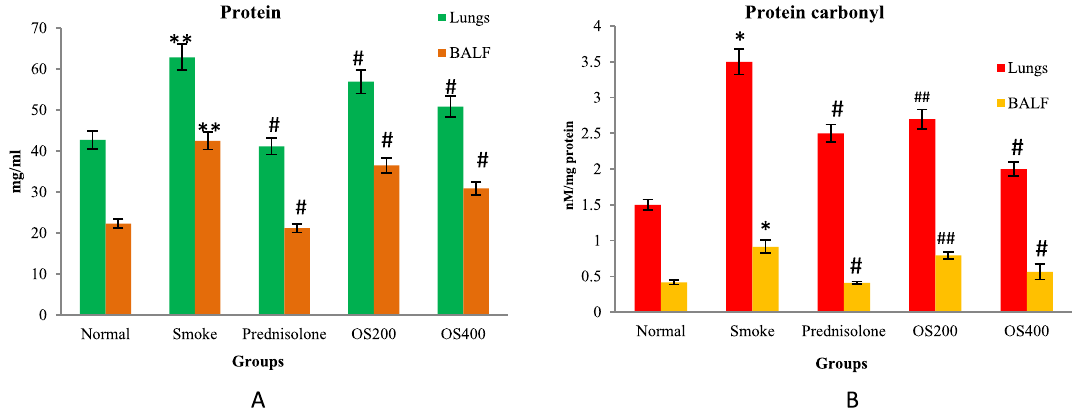
Figure 3. OLE suppressed protein and protein carbonyl content in CS exposed mice: Administration of OLE with 200 mg/kg and 400 mg/kg by i.p. route downregulated the protein concentration ( A ) and protein carbonyl content ( B ) which was upregulated by CS induction. Values are expressed as mean ± SEM. Results were analysed statistically by one way ANNOVA followed by Turkey’s test. *p < 0.01 and **p < 0.05 versus the normal group; # p < 0.01 and ## p < 0.05 versus the COPD